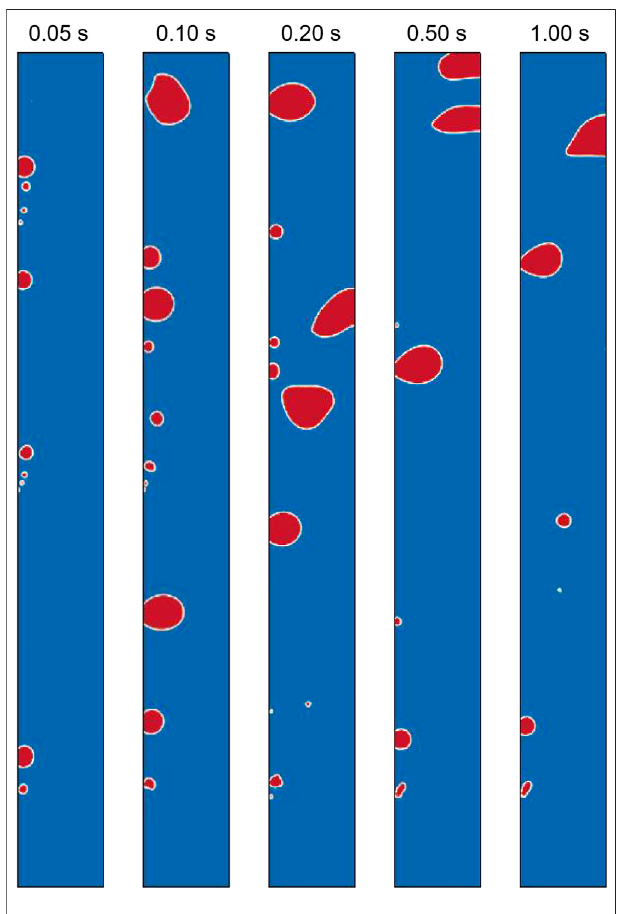
FIGURE3| Evolutionofphasedistributionatlowheat fl ux( q (cid:2) 100 W/m 2